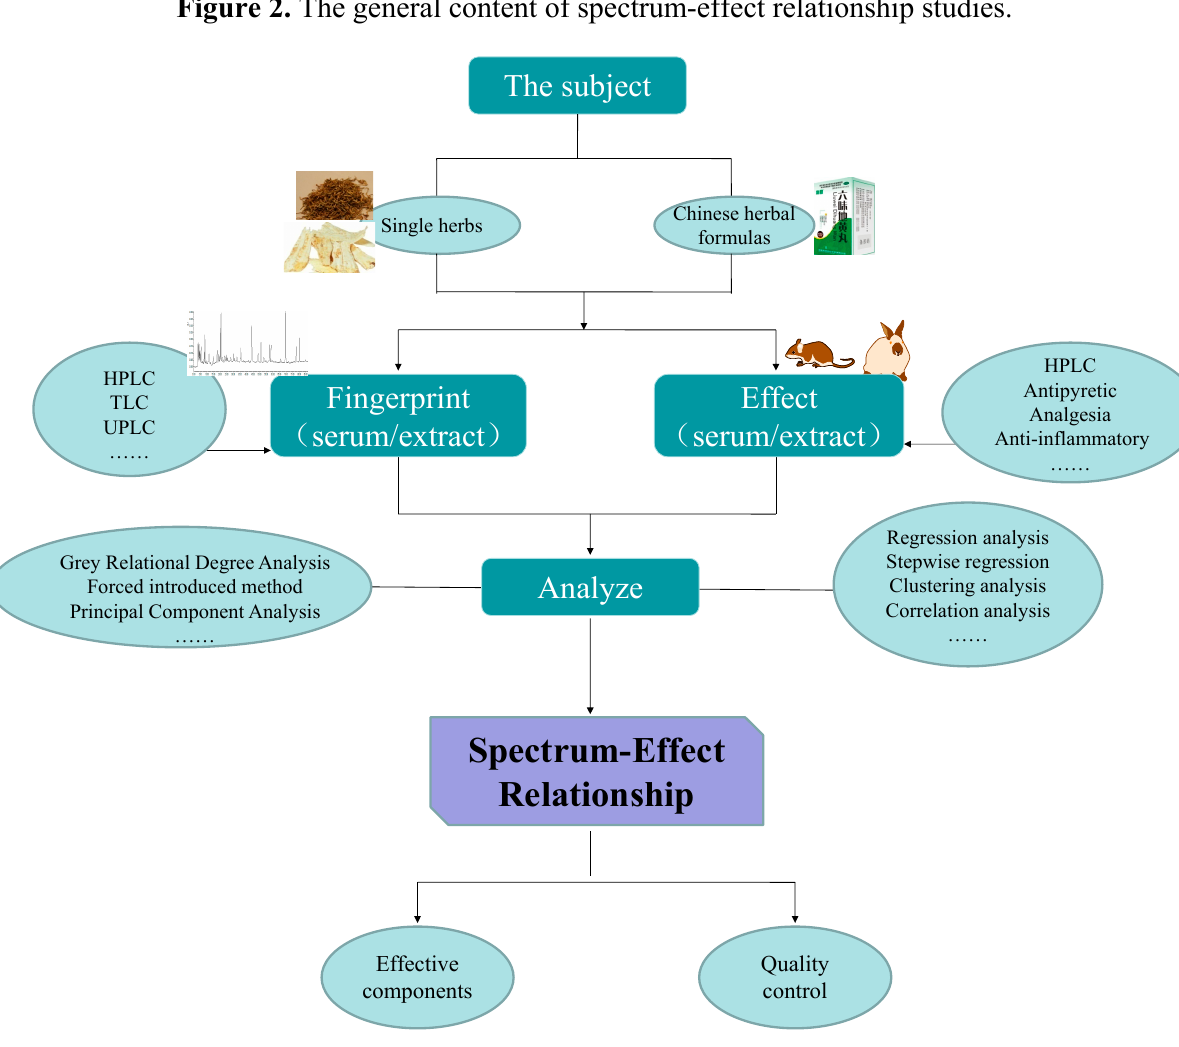
Figure 2. The general content of spectrum-effect relationship